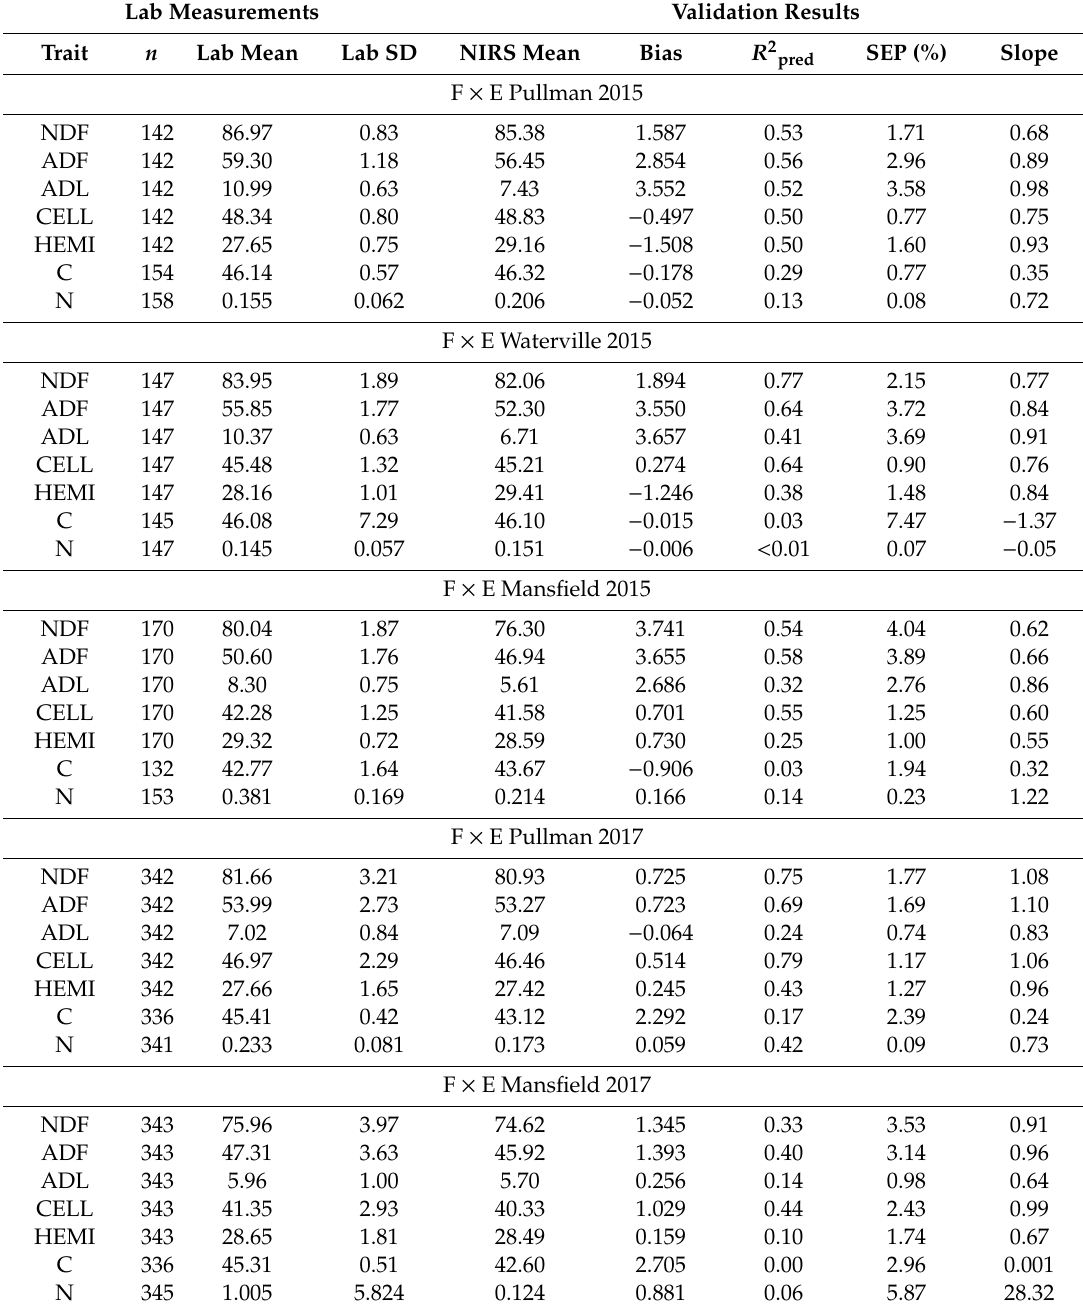
Table 4. NIRS validation statistics for all fiber and chemical constituents in five environments from the Finch × Eltan Breeding